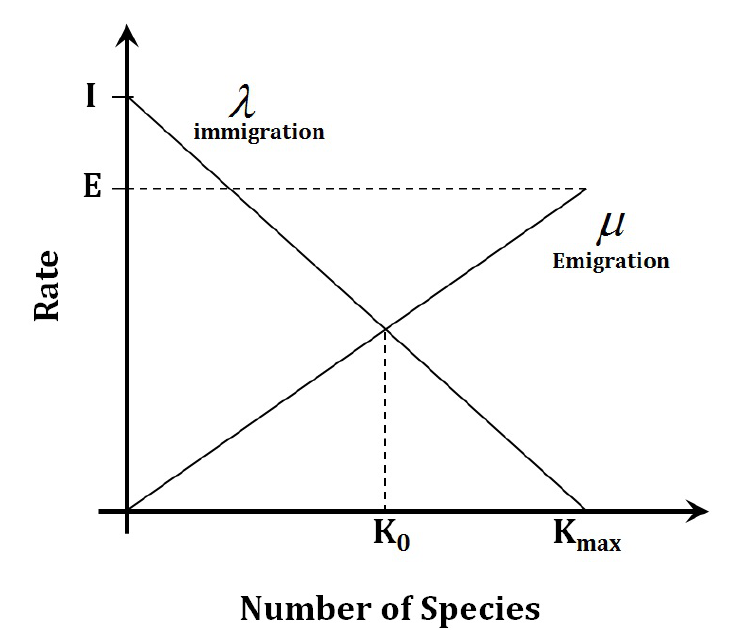
Figure 2. Linear migration model in Biogeography-based